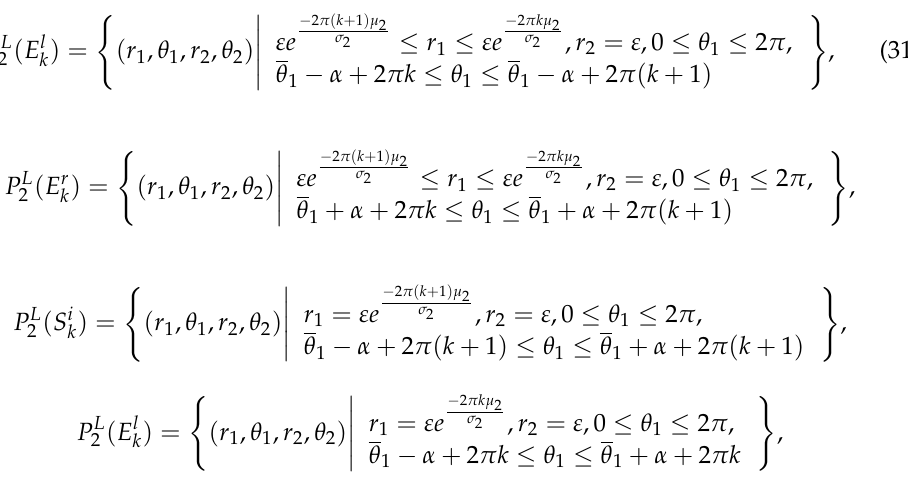
Figure 9. The three-dimensional torus structure Π 2 and the boundary descriptions.